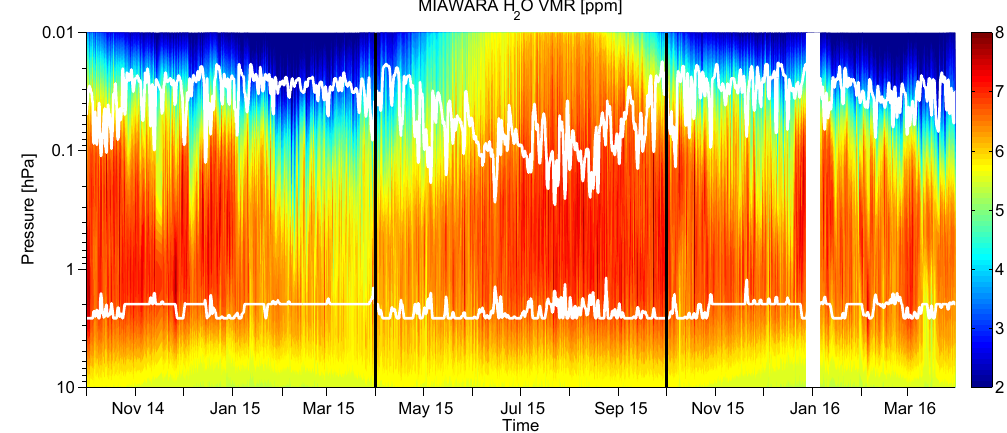
Figure 1. The water vapor volume mixing ratio (ppm) time series measured by MIAWARA between October 2014 and March 2016. The horizontal white lines indicate at which pressure levels the measurement response drops below 80%. During the more humid and warm season between April and September 2015 the data will not be used. This is marked by the vertical black lines. A measurement gap occurred between 28 December 2015 and 4 January 2016 as shown by the white